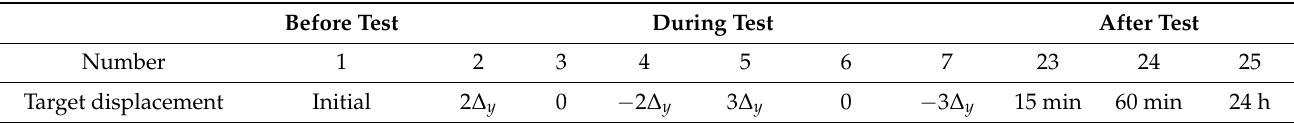
Table 10. Definition of the numbering of measurements.